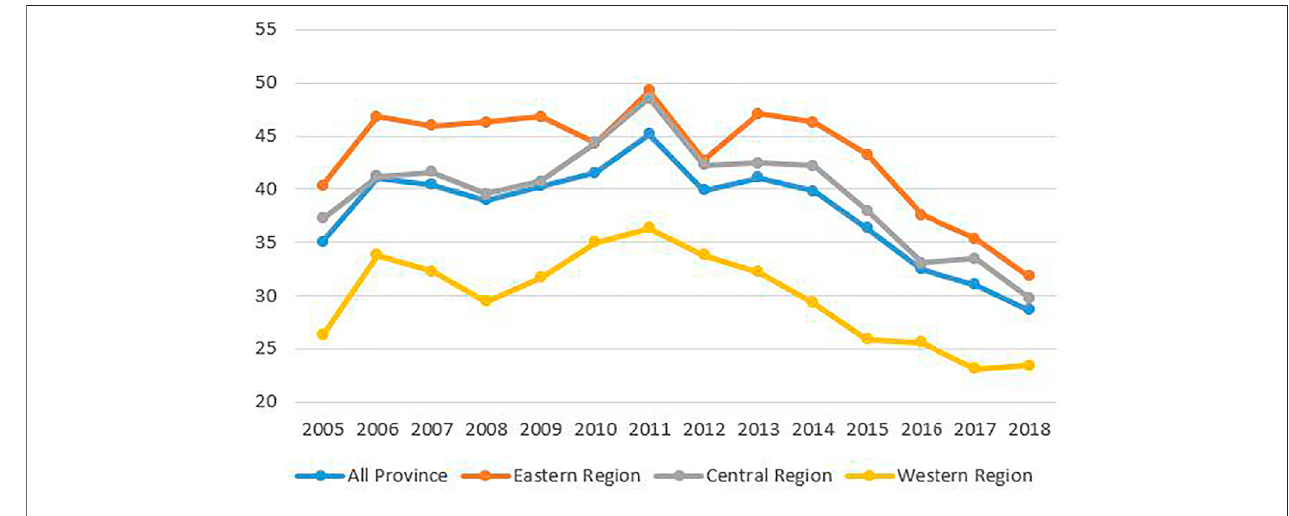
FIGURE 1 | Temporal variation of PM2.5 pollution from 2005 to 2018.